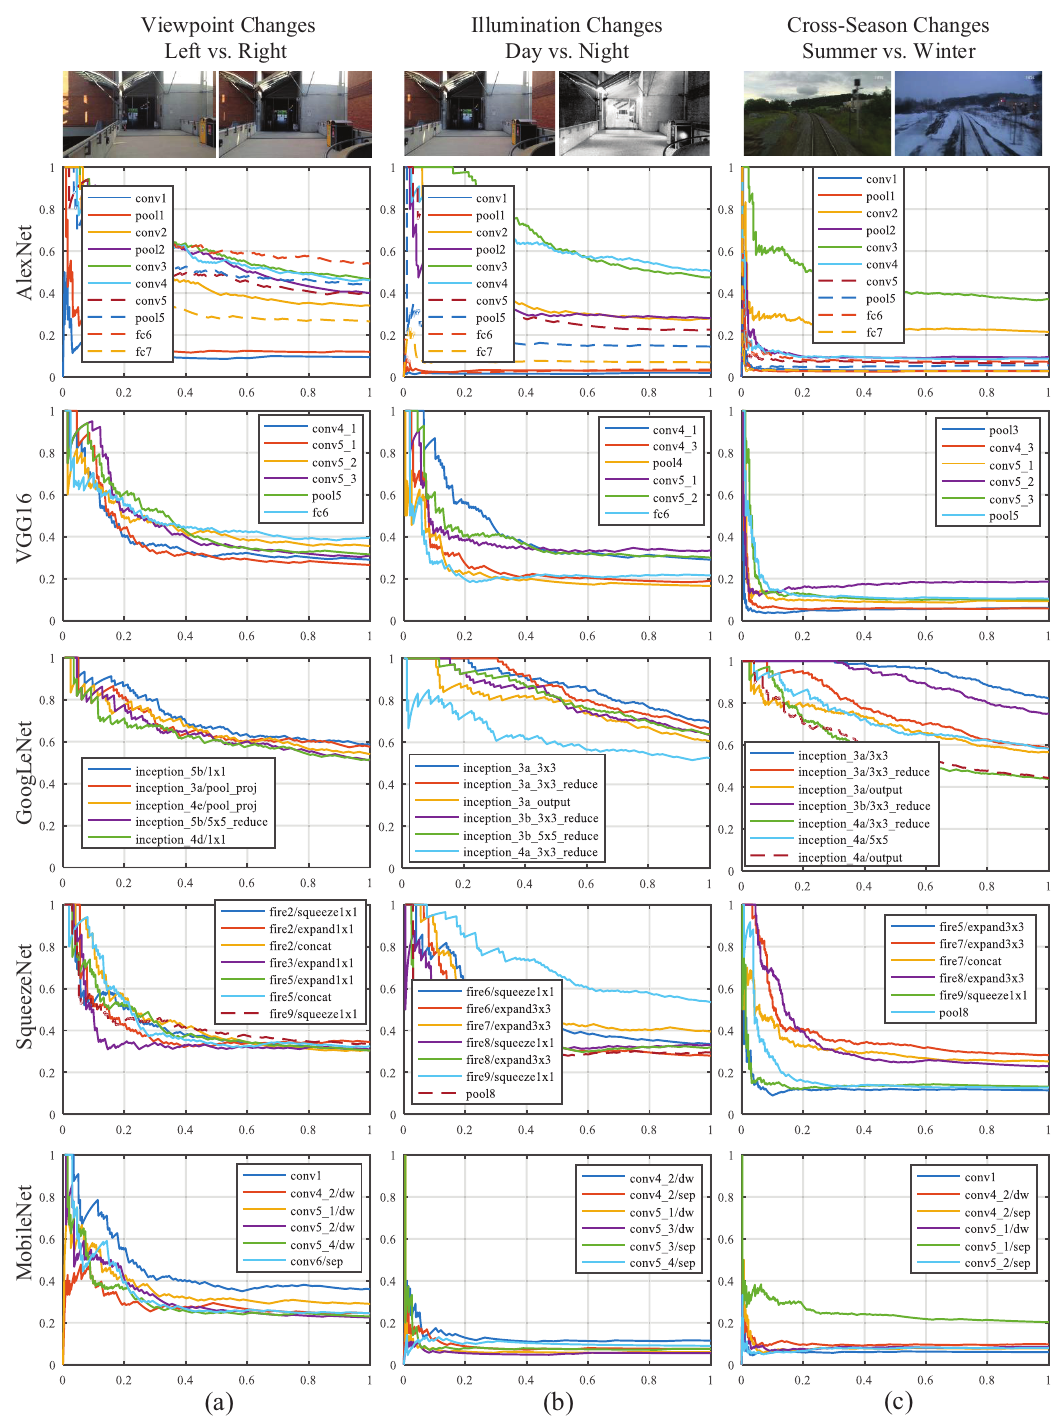
Figure 13. Precision–Recall curves comparing results about different layers of five ConvNets on different datasets: ( a ) comparison results about left vs. right in Gardens Point dataset; ( b ) comparison results about day vs. night in Gardens Point dataset; and ( c ) comparison results about summer vs. winter in Nordland